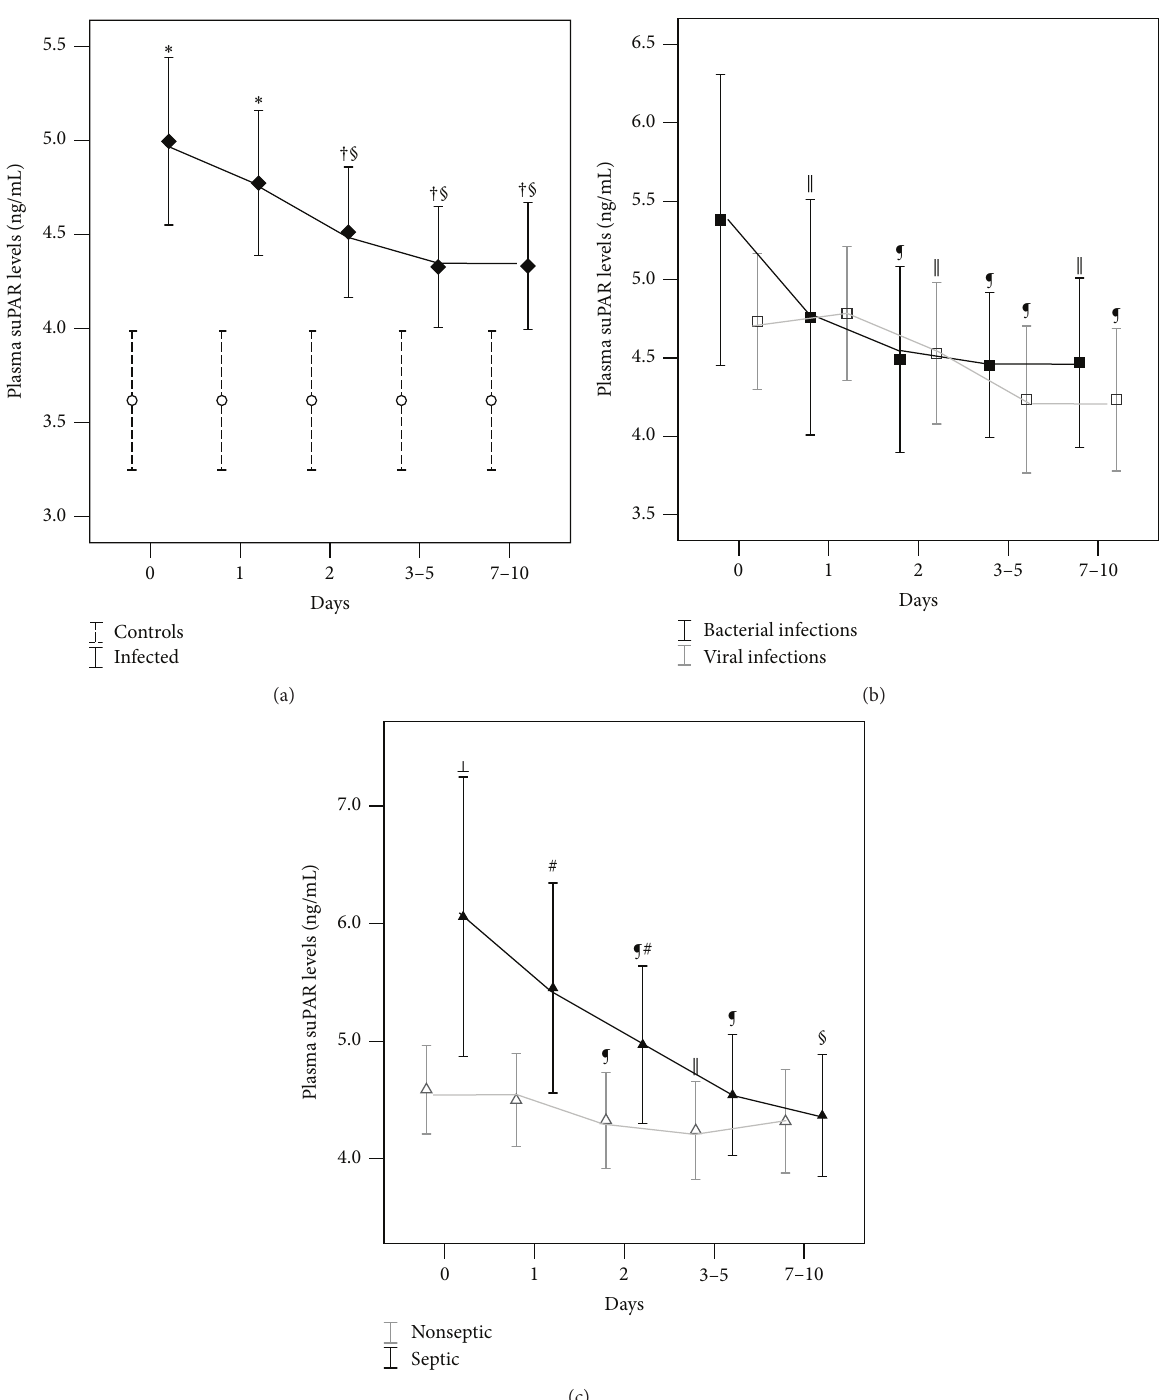
Figure 4: Repeated measurements of plasma suPAR levels during the course of infection. The bars represent mean (95% confidence interval for mean) of suPAR concentrations. (a) Decline in suPAR levels in the entire population of infected neonates ( 𝑃 < 0.001 ) and comparison with levels in controls at sequential time points. (b) Decline in suPAR levels separately for the groups of bacterial ( 𝑃 = 0.004 ) and viral infections ( 𝑃 < 0.001 ). (c) Decline in suPAR levels separately for the groups of septic ( 𝑃 < 0.001 ) and nonseptic ( 𝑃 = 0.016 ) infected neonates. ∗ 𝑃 ≤ 0.001 , † 𝑃 ≤ 0.01 , compared with controls; § 𝑃 ≤ 0.001 , ¶ 𝑃 ≤ 0.01 , ‖ 𝑃 ≤ 0.05 , compared with baseline; ⊥ 𝑃 ≤ 0.01 , # 𝑃 ≤ 0.05 , compared with nonseptic